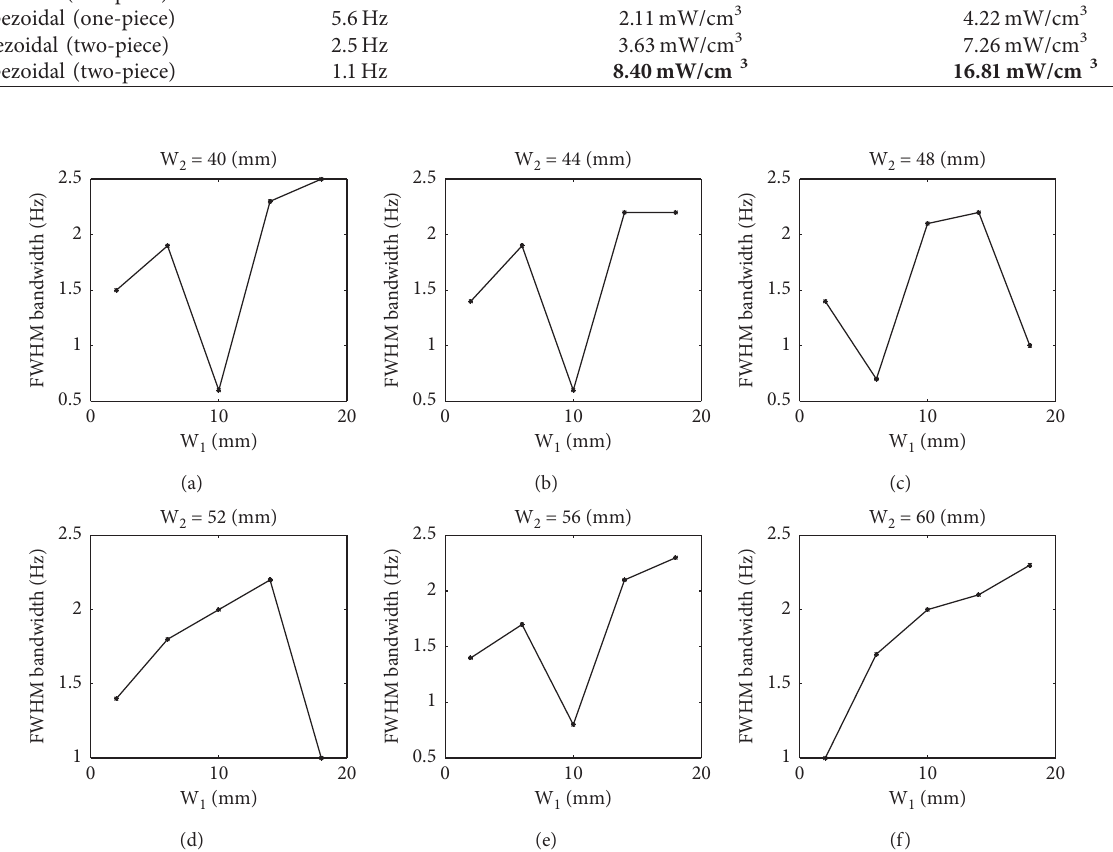
Table 3: FWHM bandwidth, the min./max. real power density of various trapezoidal bimorph beams [6, 8]. The one-piece trapezoidal bimorph design has the same dimension of the two-piece trapezoidal bimorph for the comparison. Design